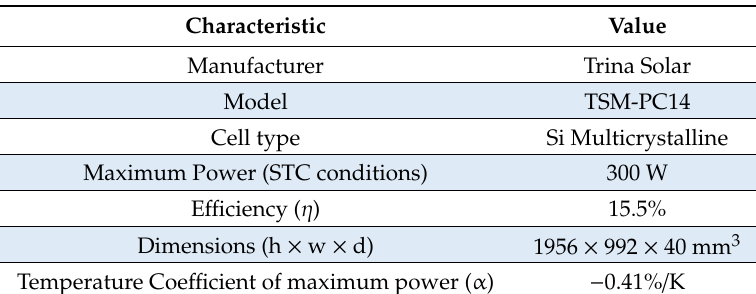
Table 5. Solar panel characteristics [75] .